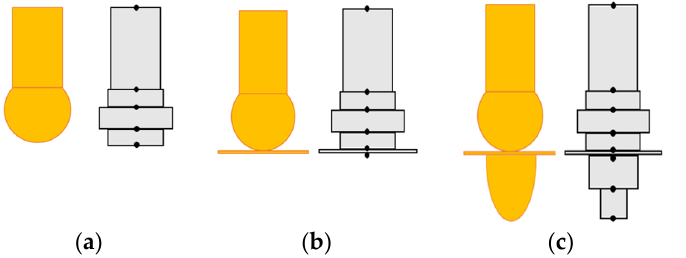
Figure 7. Modeling consideration details of footings for each model in the NK-UTWind code analysis: ( a ) Sphere, ( b ) Plate, and ( c ) Semi ‐ Spheroid models.